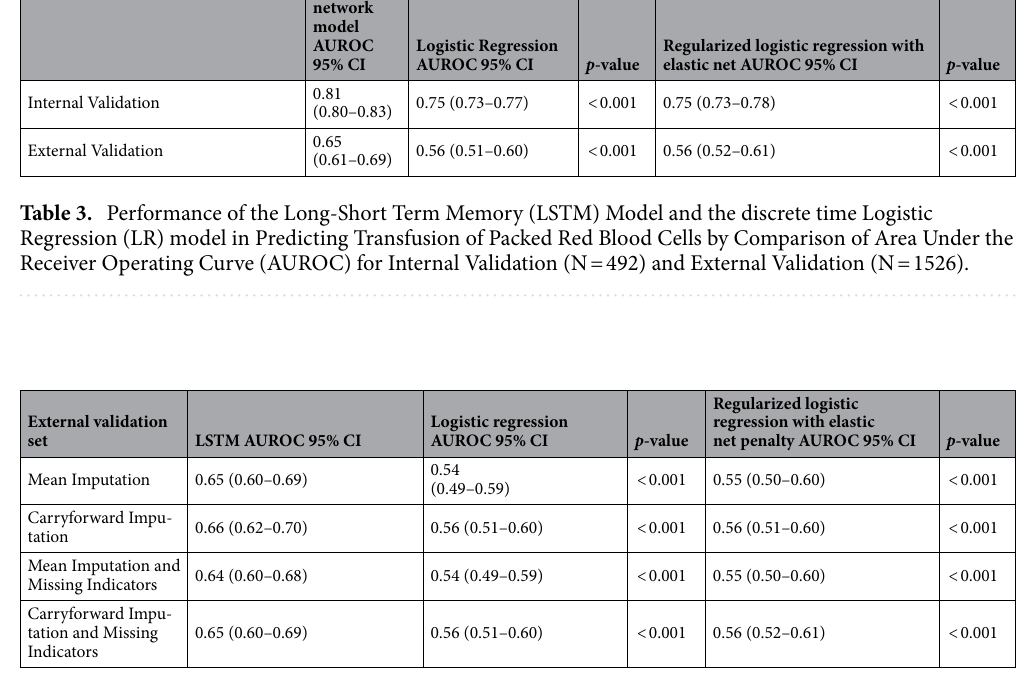
Table 4. Comparison on external validation only of the overall performance of Long-Short Term Memory network model compared to the Logistic Regression model with different imputation methods to address missingness in the first 24 h after admission for all patients admitted to the Intensive Care Unit with Acute Gastrointestinal